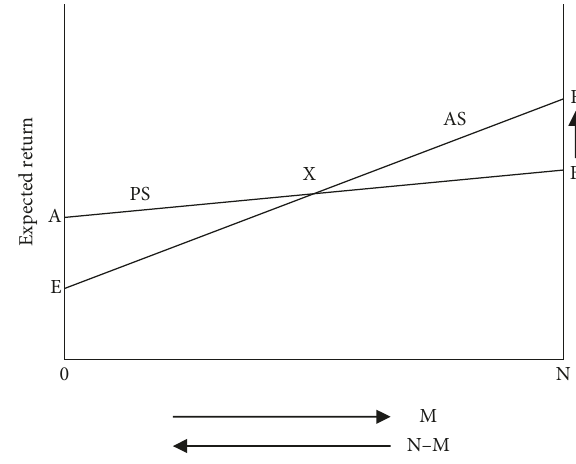
Figure 2: Self-resistance slope model.